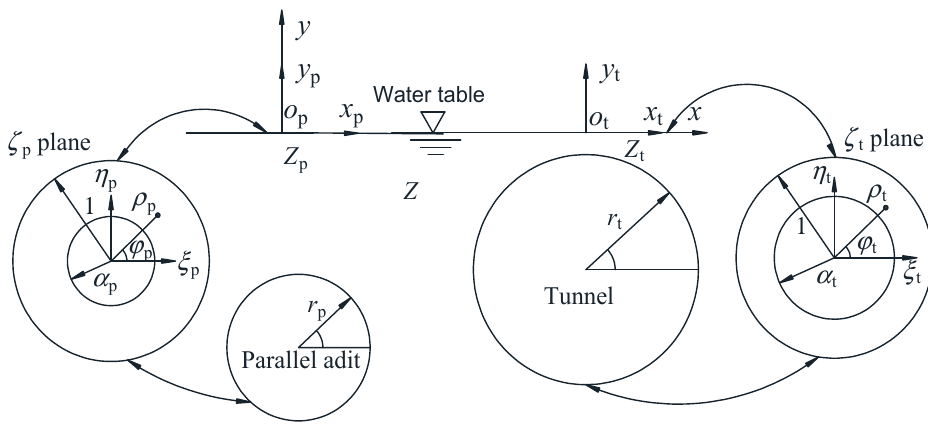
Figure 3. Plane of conformal mapping.